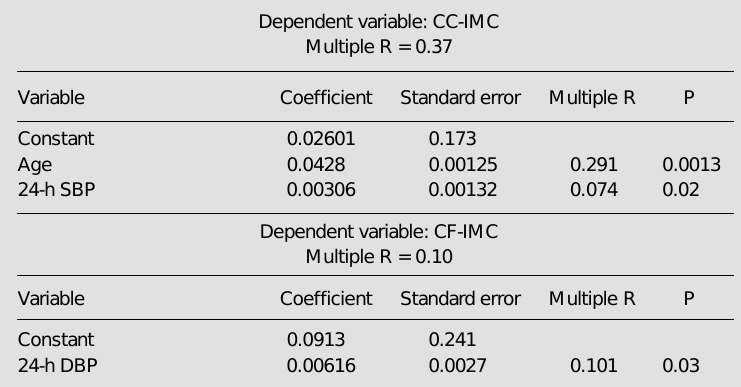
Table 4 - Results of forward stepwise multiple regression of factors influencing common carotid (CC)- and common femural (CF)-intima-media complex (IMC) in hypertensive patients (N = 52). SBP, Systolic blood pressure; DBP, diastolic blood